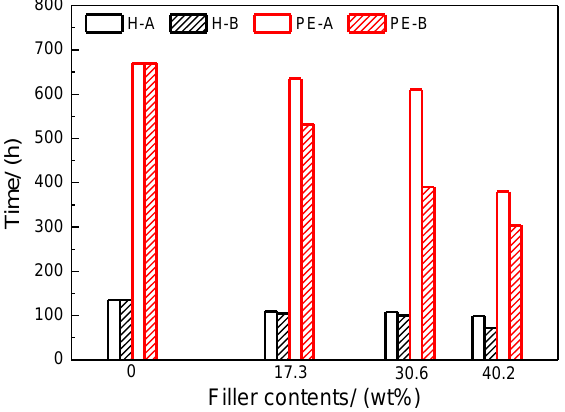
Figure 13. Time consumed of samples at 90% of gloss retention.